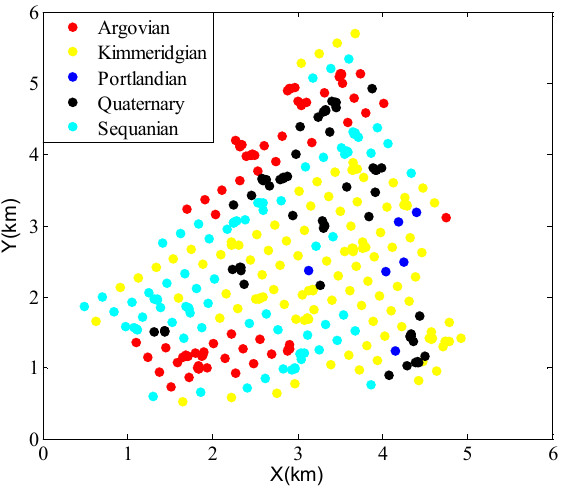
Figure 5. Jura lithology data set with 359 samples.